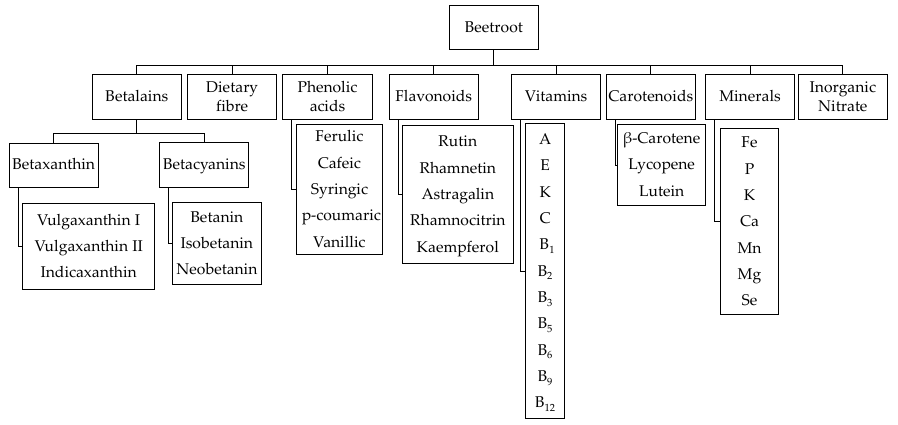
Figure 1. Scheme of the main bioactive compounds present in beetroot.